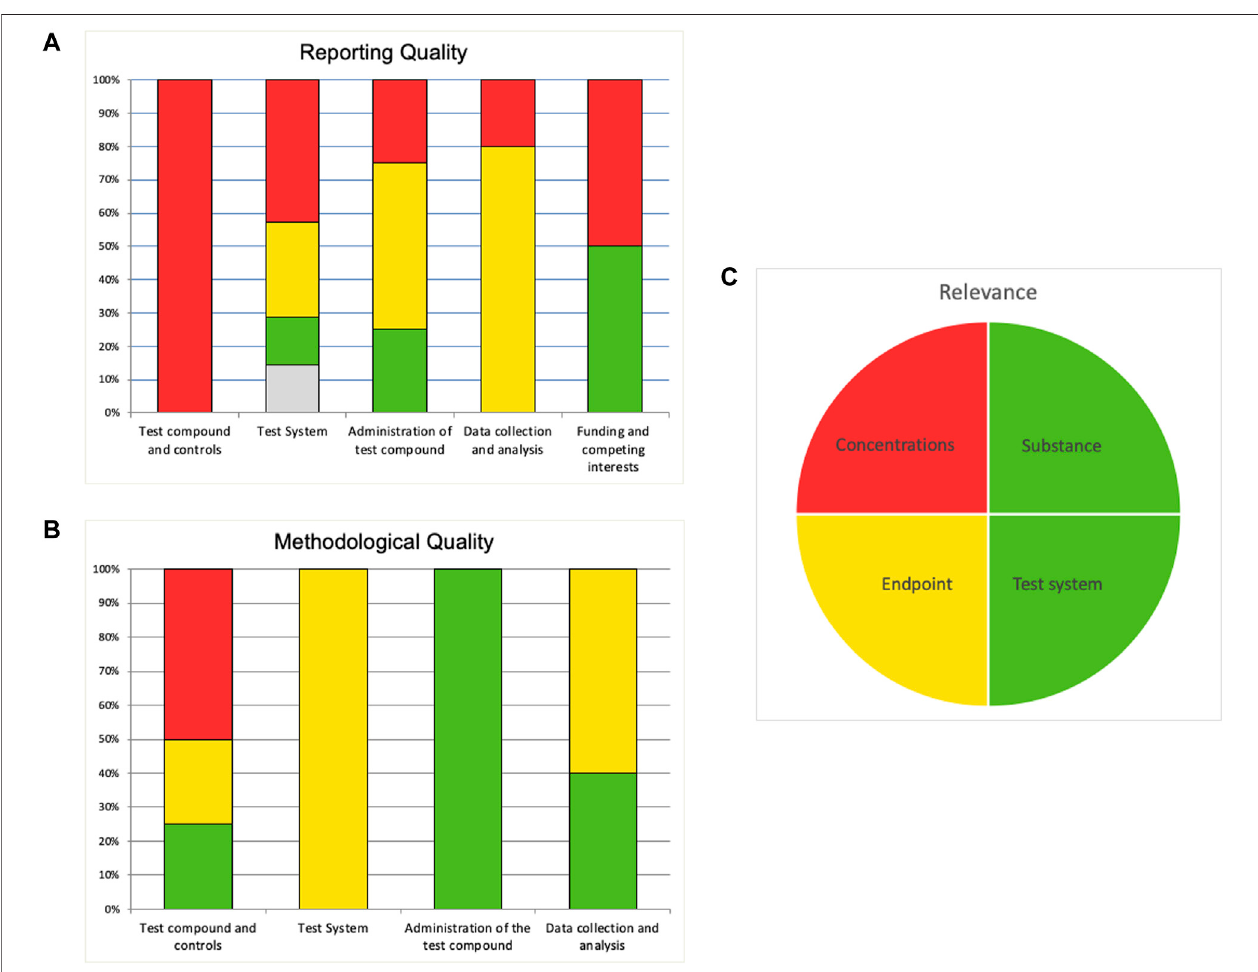
FIGURE4 | Exampleofacolourpro fi leforan invitro studyevaluatedintheSciRAP invitro tool. “ Reportingquality ” (A) and “ Methodologicalquality ” (B) areillustratedin bar diagrams. Each bar shows the percentageof criteria judged as “ ful fi lled ” (green) , “ partially ful fi lled ” (yellow) , “ not ful fi lled ” (red) and “ not determined ” (grey) , taking into accountiftheweighthasbeenincreasedforanycriteria.Criteriathathavebeenremovedarenotincluded.Evaluationofrelevanceisillustratedinapiechart (C) .Ifanitemwas evaluatedas “ directlyrelevant ” itisshown asgreen,ifitwasjudgedas “ indirectlyrelevant ” itisshownasyellow,andifitwasjudgedas “ notrelevant ” itisshown asred.